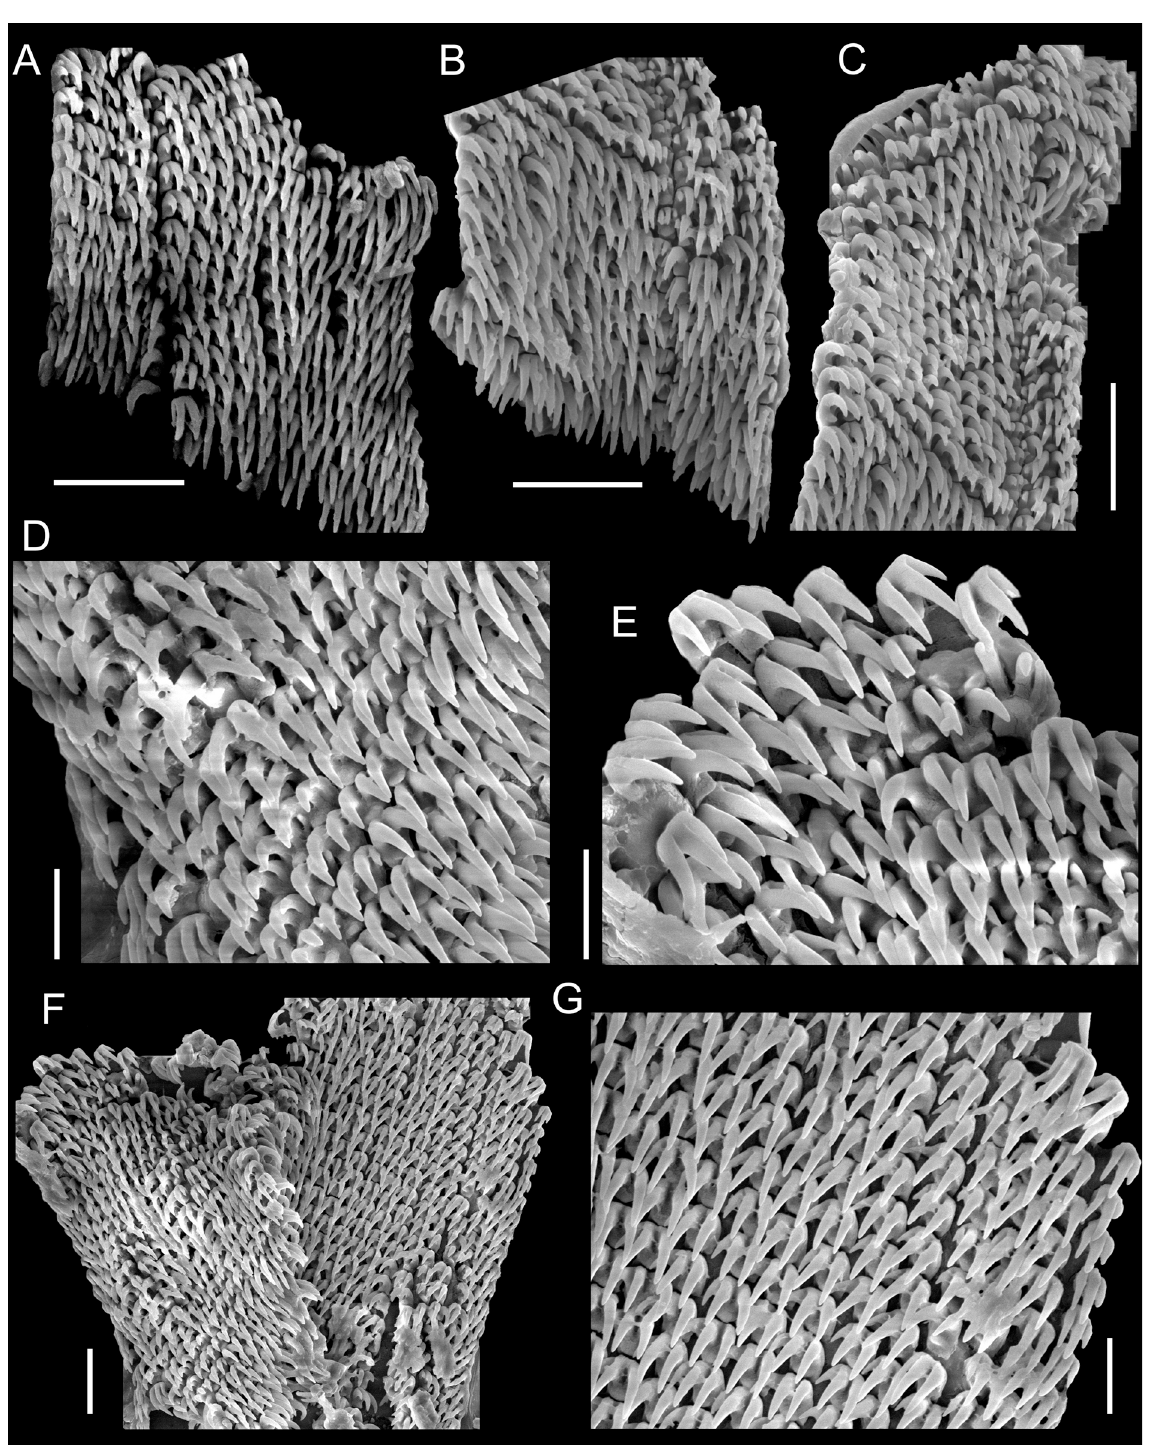
Fig. 29. Strobiligera gaesona (Dall, 1927), radula. A–C . MZSP 53685. D–G . MZSP 53697. Scale bars: A–C, F = 10 µm; D–E, G = 5